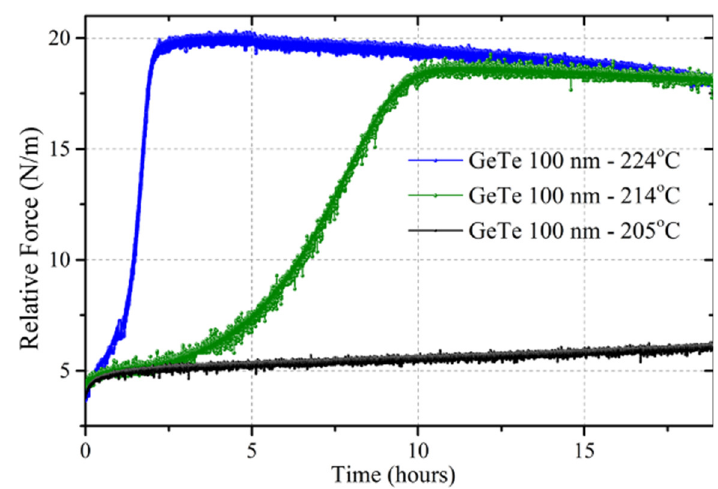
Figure 3. Relative force as a function of time for a 100 nm thick GeTe film deposited on Si and capped with 10 nm SiO 2 . Reported temperatures are 224, 214 and 205 °C, respectively.